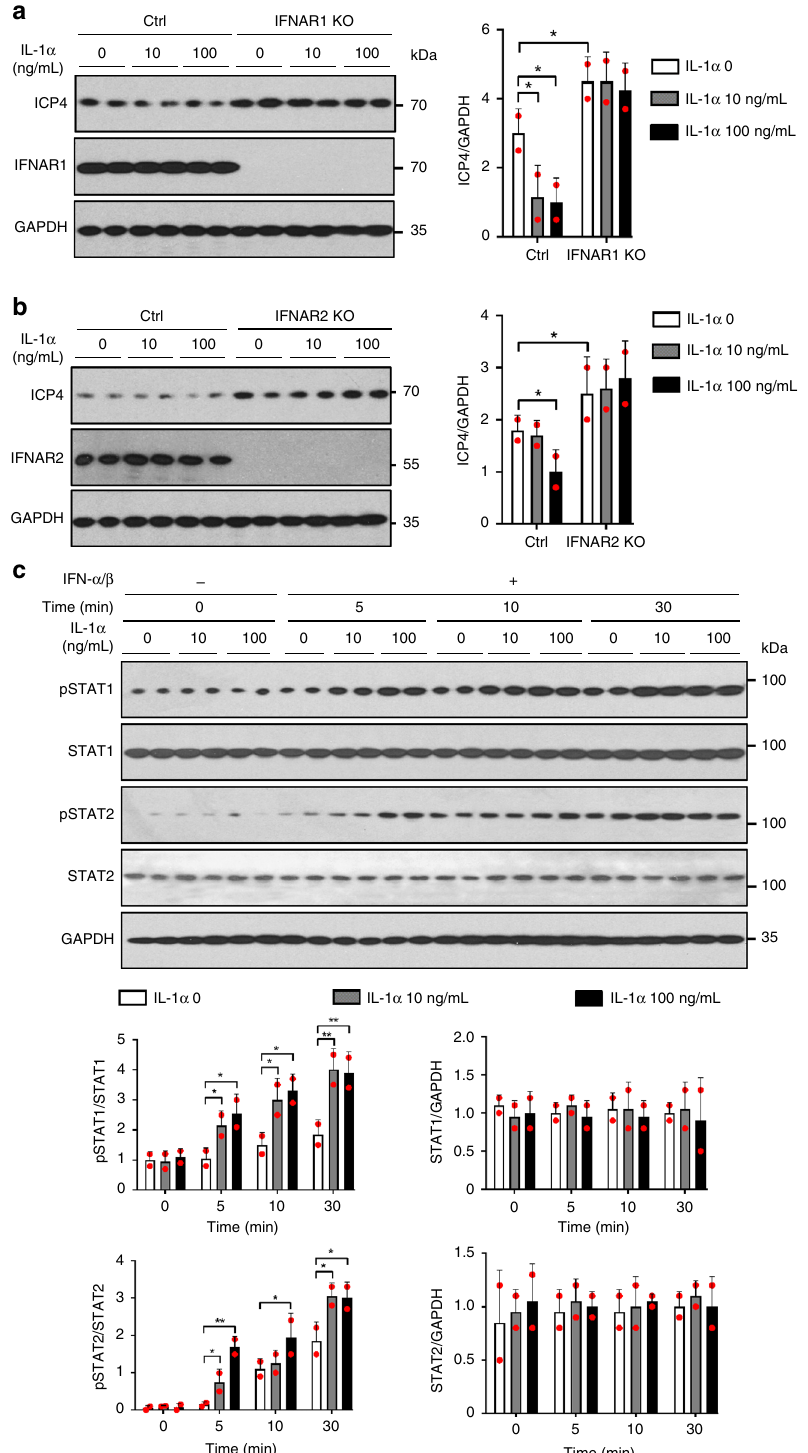
Fig. 10 IL-1 promotes enhanced type I IFN signaling through IFNAR in human cells. a , b Gene editing was performed in human keratinocytes using control (Ctrl), IFNAR1 ( a ) or IFNAR2 ( b ) gRNAs and Cas9. Cells were treated with medium only or IL-36 β , infected with HSV-1 and analyzed by western blotting. c Cells were pre-treated with medium only or IL-1 α followed by IFN- α / β . STAT1/2 activation was examined by western blotting. Quantitative data are shown as means ± SD. * p < 0.05; ** p < 0.01 (one-way ANOVA, n = 2 biologically independent samples per treatment group). Each red dot represents a single data point. Source data are provided as a Source Data fi